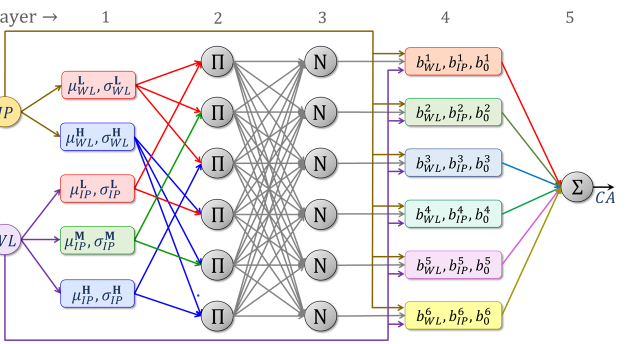
Figure 13. Adaptive Neuro-Fuzzy Inference System. Shown are the inputs and the five layers of an ANFIS.